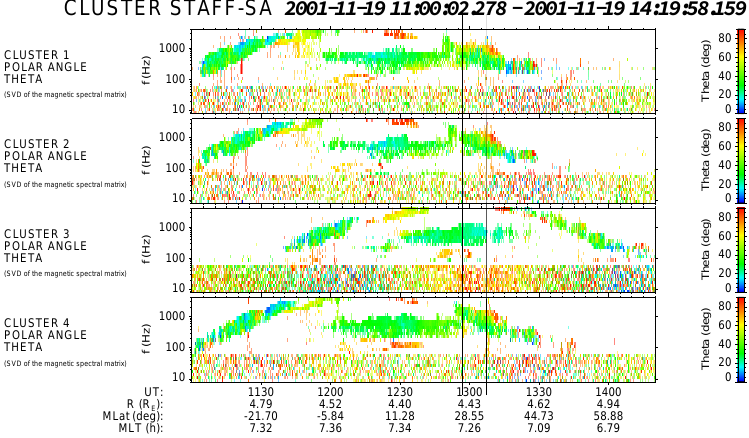
Fig. 2. Spectrograms of the wave normal angles for the event of Fig. 1 for the four SC. Values are color-coded according to the scales on the right. The two vertical lines indicate the time interval where the ray tracing is